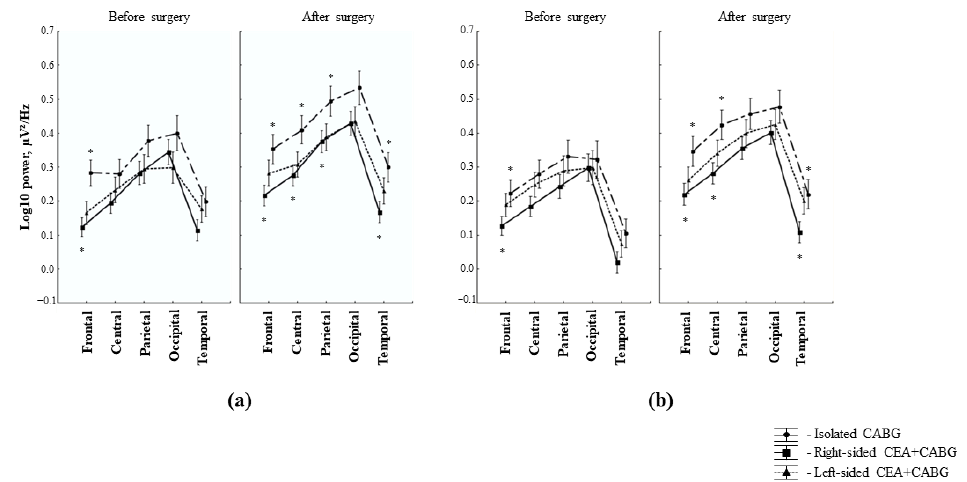
Figure 5. The topography of the postoperative theta1 rhythm power changes in the patients under- going isolated CABG and simultaneous intervention (CABG+CEA): ( a ) left hemisphere; ( b ) right hemisphere; error bars denote SE, *— p < 0.05 Newman–Keuls multiple comparison test for between- group